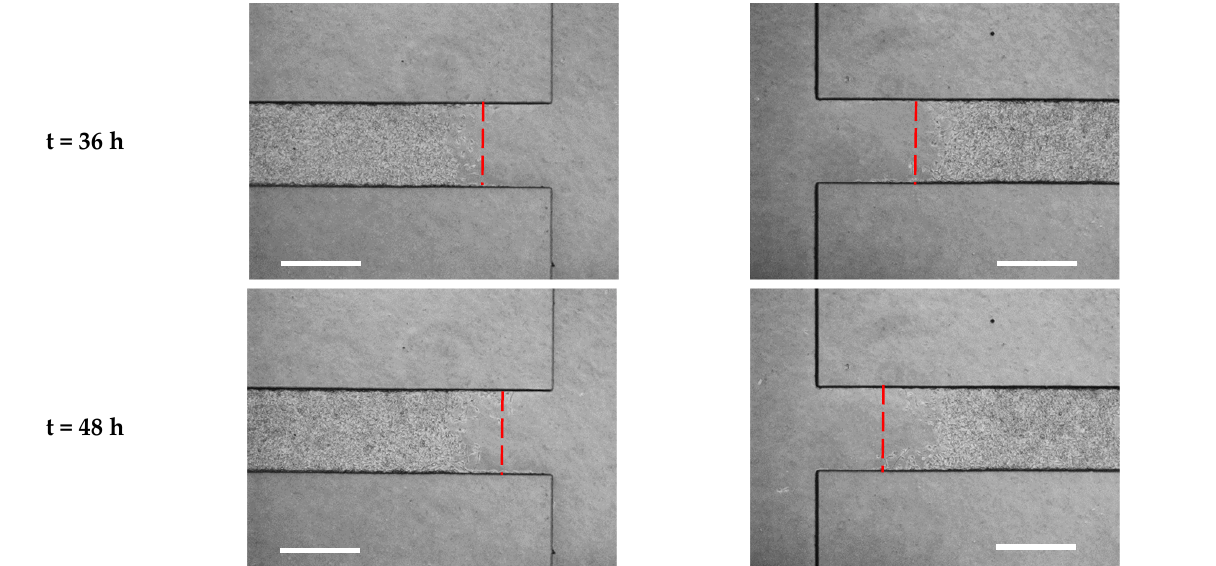
Figure 5. Time-lapse images from cell migration on the substrates of ( A ) glass, ( B ) polystyrene ( C ) PDMS after 0, 12, 24, 36 and 48 h, scale bar = 600 µm.